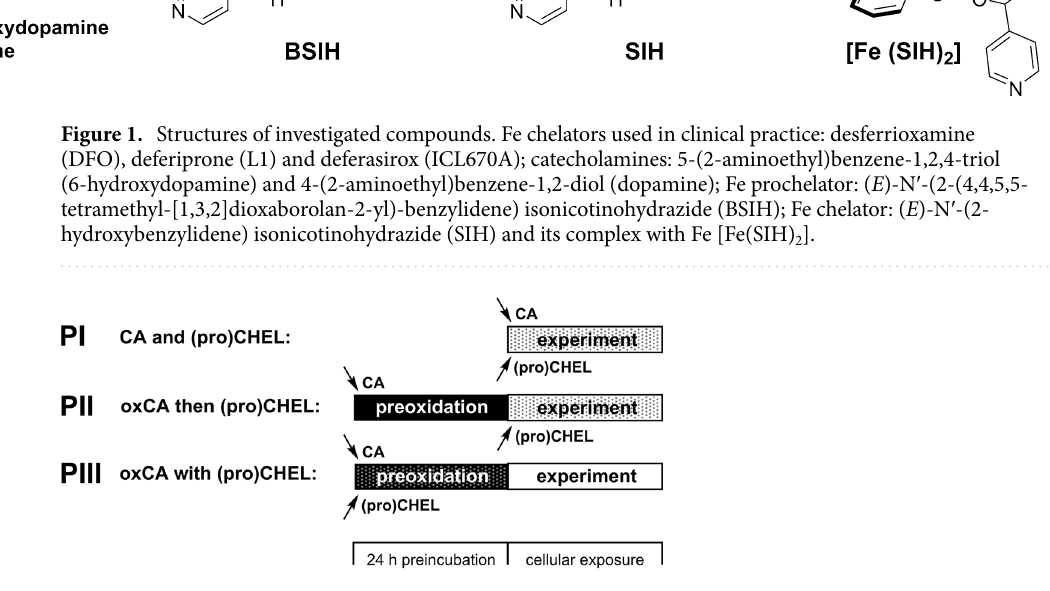
Figure 2. Overview of the cytotoxicity protocols used in this study. Work solutions of catecholamine (CA—6- hydroxydopamine or dopamine) were either freshly-prepared before the cellular exposure (protocol PI ) or 24 h-preincubated (i.e., left spontaneously oxidize; oxCA) at 37 °C (protocols PII and PIII ). The Fe chelator or prochelator under investigation [(pro)CHEL] was added to the solution with catecholamine either at the start of the cellular exposure (protocols PI , PII ) or at the beginning of 24 h preincubation of catecholamine (protocol PIII